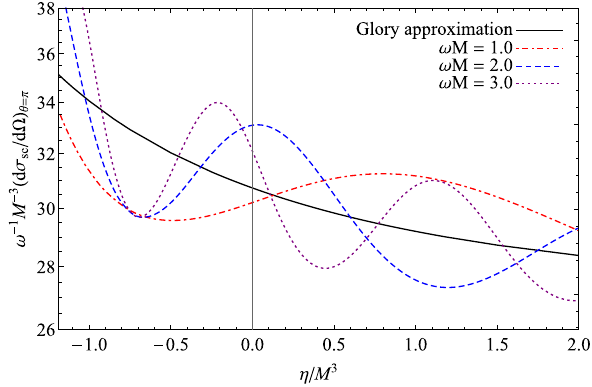
Fig. 7 Amplitudeoftheglory (θ = π) asafunctionofthedeformation parameter η . We notice that the numerical results oscillate around the glory approximation (monotonically decreasing solid black